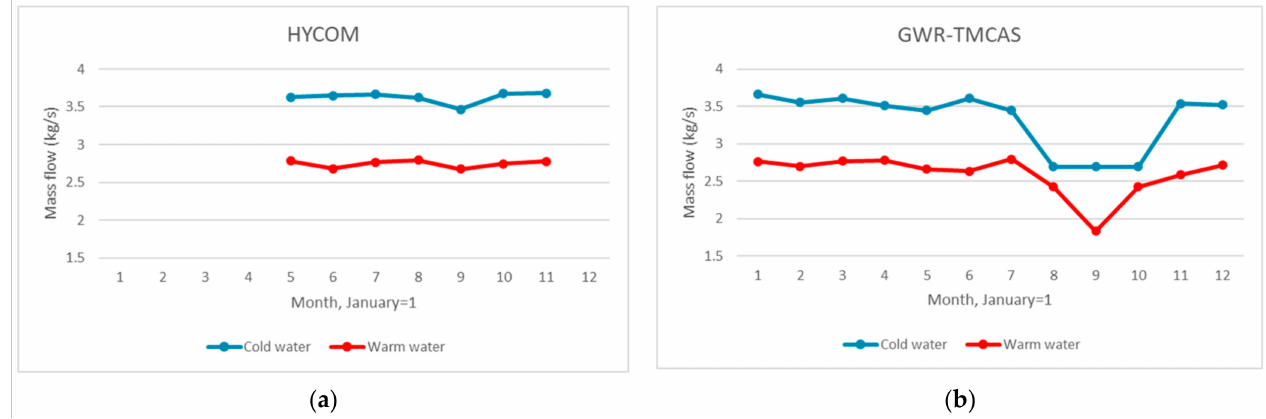
Figure 6. Cold water and warm water mass flow required along the year for HYCOM ( a ) and GWR-TMCAS ( b ) to provide 1 kWe of energy